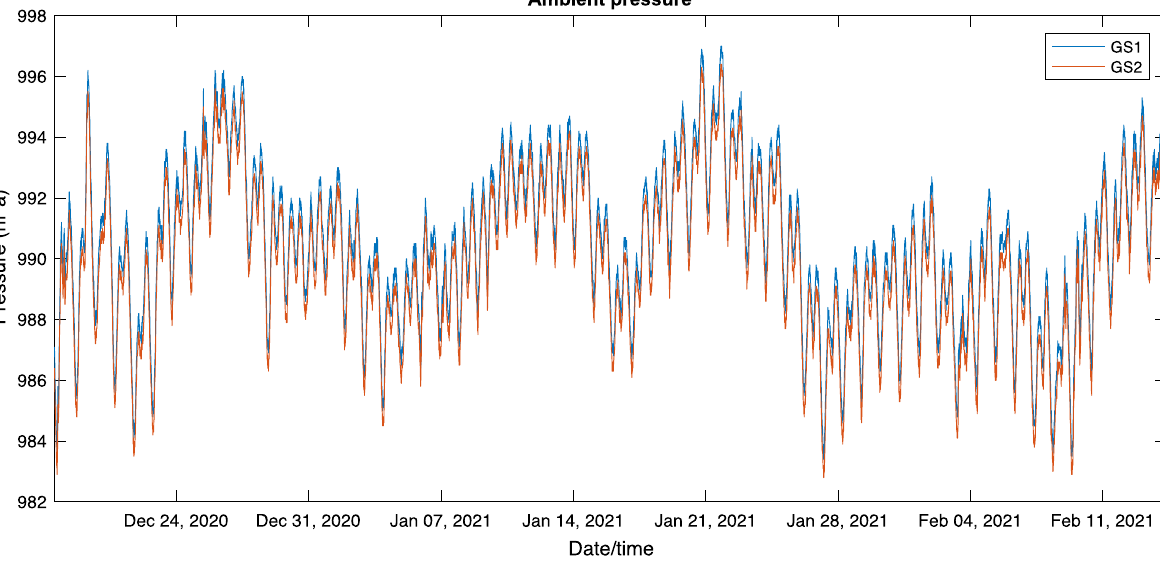
Fig. 9 Ambient pressure as reported by the two gas monitoring stations (GS1 and GS2). Again, note the cyclical 24 h periodicity due to day- night transition. On average 990.6 ± 2.5 hPa for GS1 and 990.0 ± 2.5 hPa for